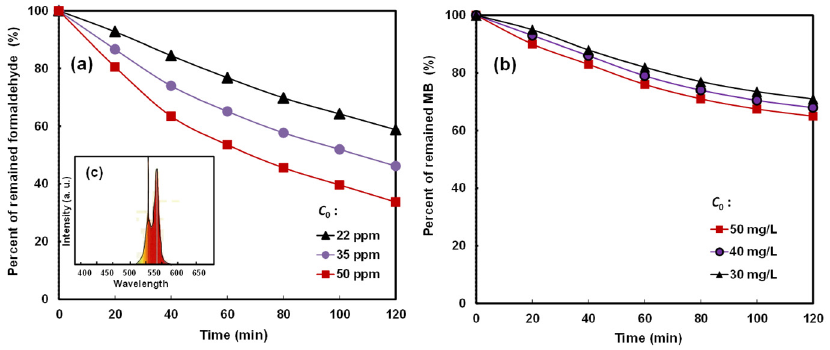
Figure 8. Visible light photocatalytic degradation of ( a ) HCHO and ( b ) MB with various C 0 over N/TiO 2 photocatalyst. ( c ) Emitting spectrum of the LED visible light lamps. N/TiO 2 photocatalyst. ( c ) Emitting spectrum of the LED visible light